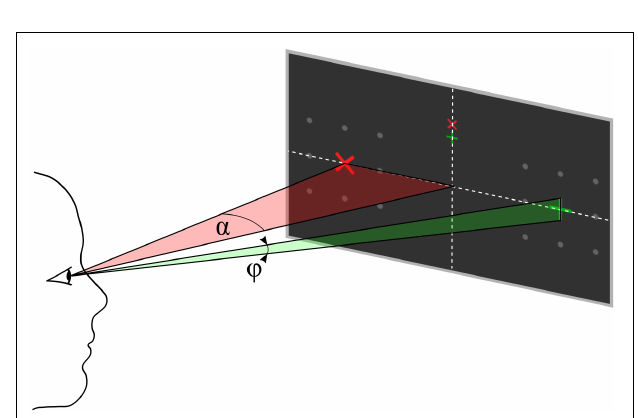
FIGURE 2 | Parameter definition for eccentricity α and symbol size ϕ , both defined as visual angles. The participant’s gaze is directed to one of the upper central